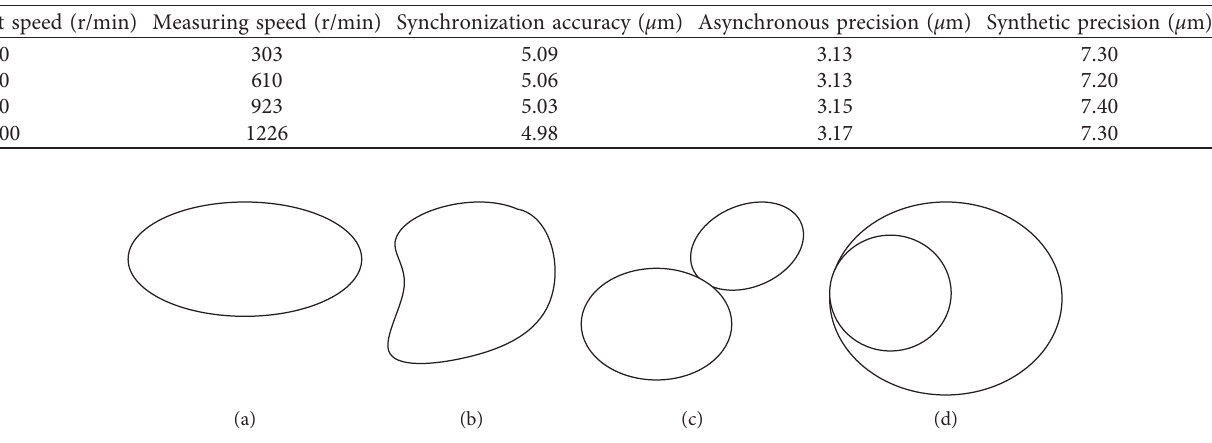
Table 4: Average rotation accuracy of the spindle at different speeds.